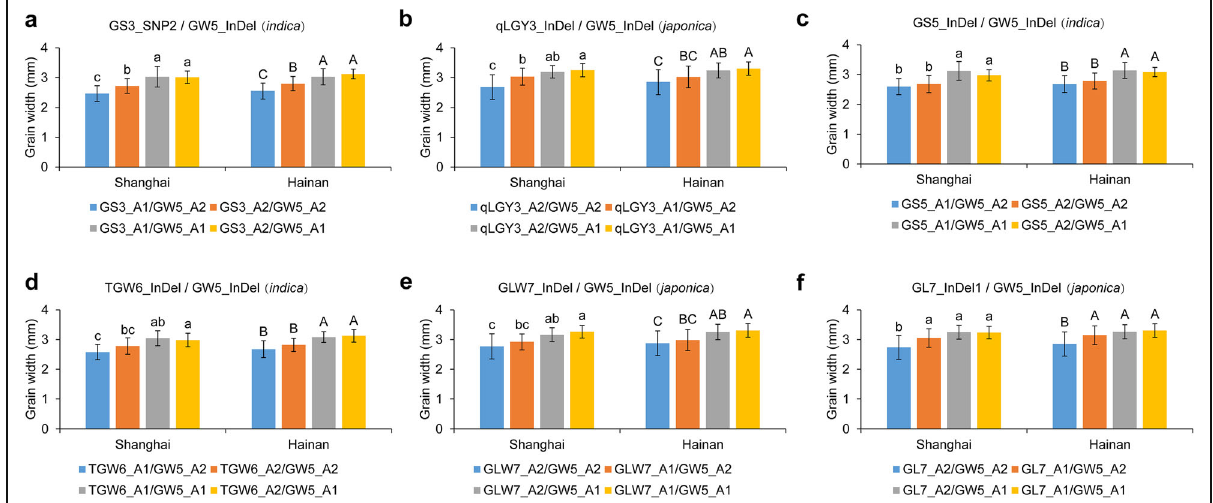
Fig. 6 Impact of GW5 alleles on grain width control of six other loci . Four allele combinations can be obtained between GW5_InDel and six other FNPs in either the indica or japonica subspecies, namely GS3_SNP2 ( a ), qLGY3_InDel ( b ), GS5_InDel ( c ), TGW6_InDel ( d ), GLW7_InDel ( e ) and GL7_InDel1 ( f ). A1 represents allele 1 (NIP-type) and A2 represents allele 2 (non-NIP-type). Multiple comparisons by Tukey ’ s test were performed for data from Shanghai and Hainan, and different letters indicate significant differences among the four allele